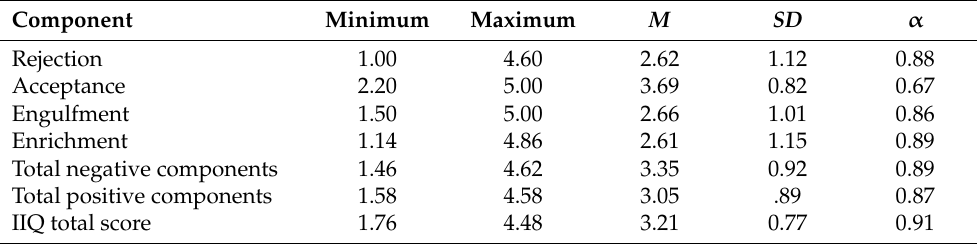
Table 1. Descriptive statistics and Cronbach’s alphas of the illness identity questionnaire (IIQ) components and total